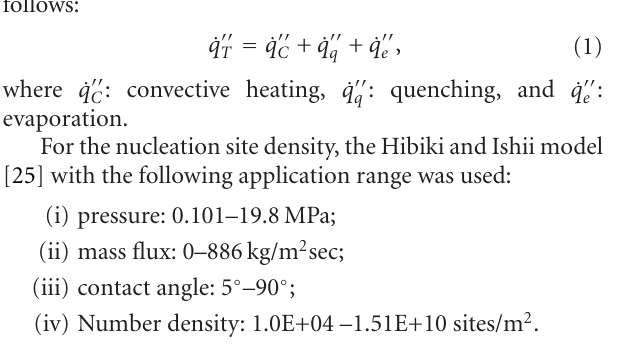
Table 5: Bundle average spacer pressure loss coe ffi cients